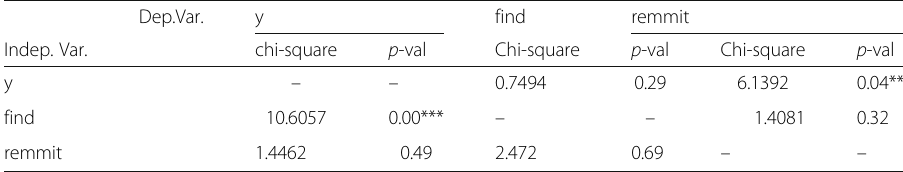
Table 13 VAR Granger Causality/Block Exogeneity Wald Test Dep.Var. y find remmit Indep. Var.